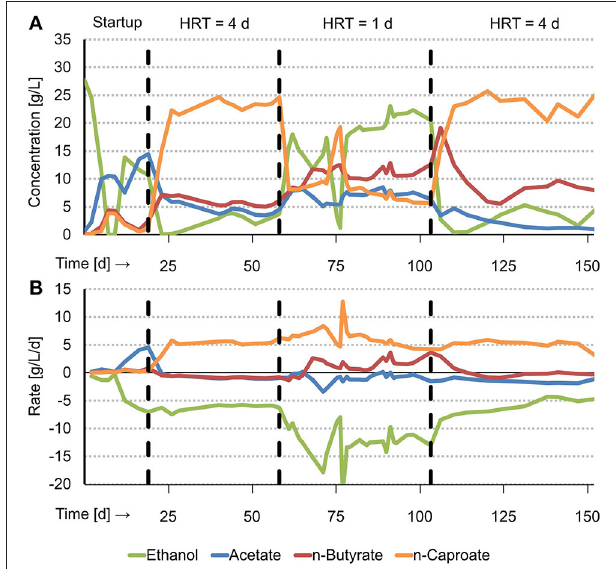
FIGURE 1 | Graphical summary of experimental results with concentrations over time (A) and net production and consumption rates over time (B) . T = 30 ◦ C, pH = 6.8, V = 1L, CO 2 loading rate = 1.0 L CO2